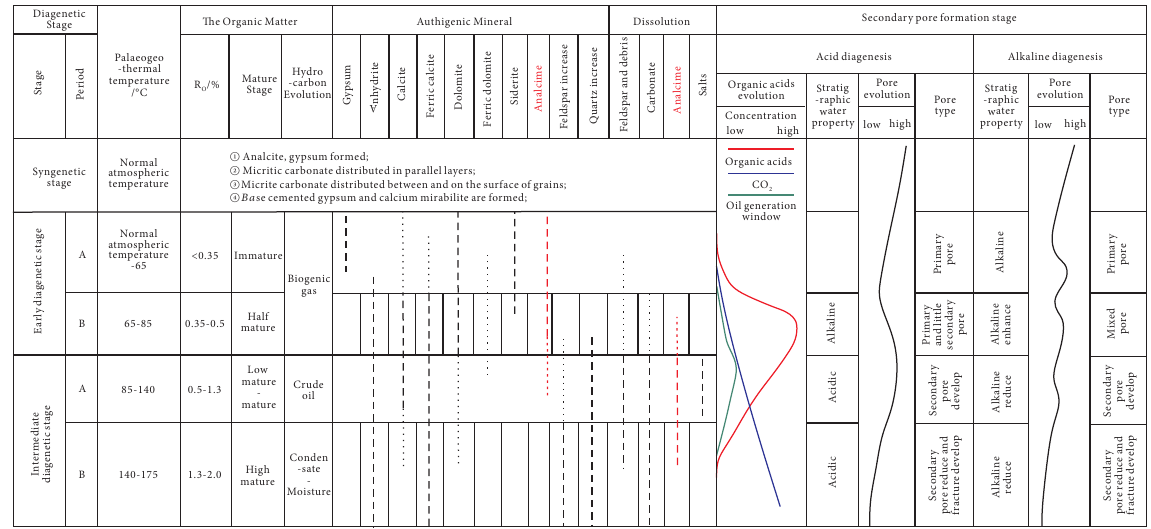
Figure 15: Relationships among precipitation-dissolution of analcime and the diagenesis stage of clastic rocks in alkaline water (modified according to Sun et al., 2014)